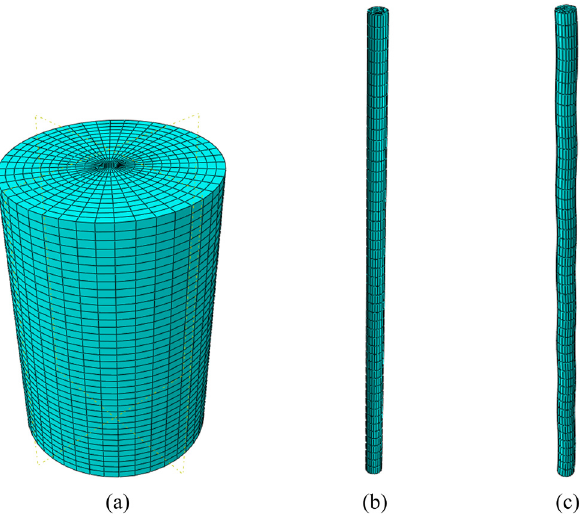
Figure 9: Dimensions of elements in the model and meshed model. ( a ) Fiber and matrix, ( b ) straight fi ber, and ( c ) crimped fi